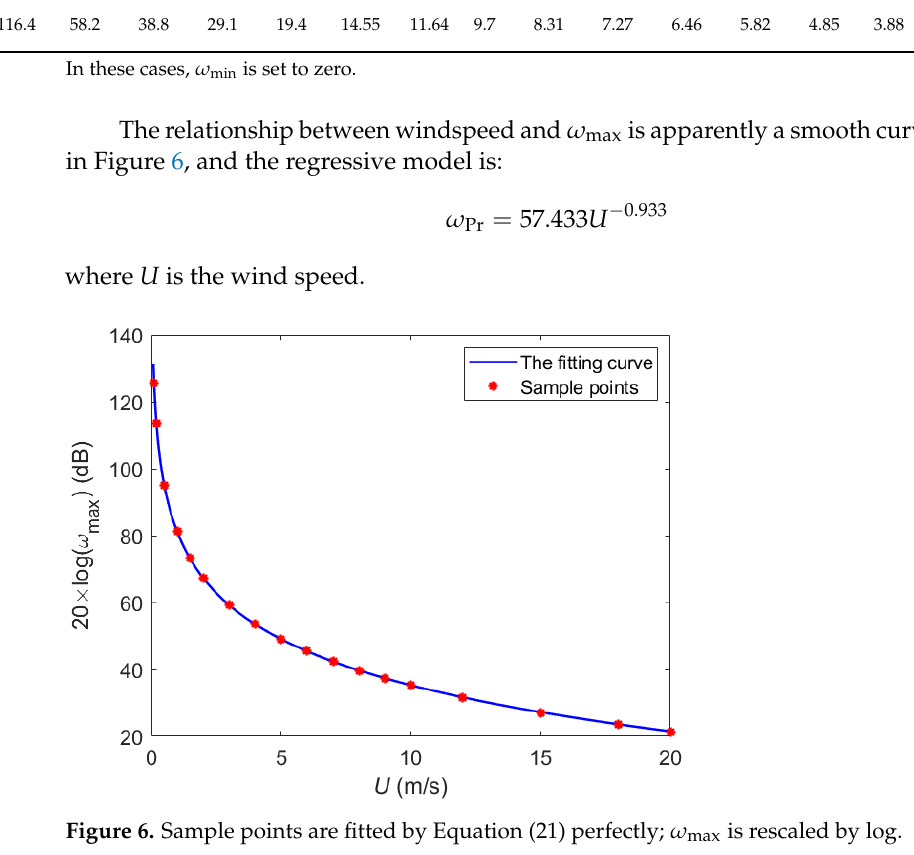
 is rescaled by log. max